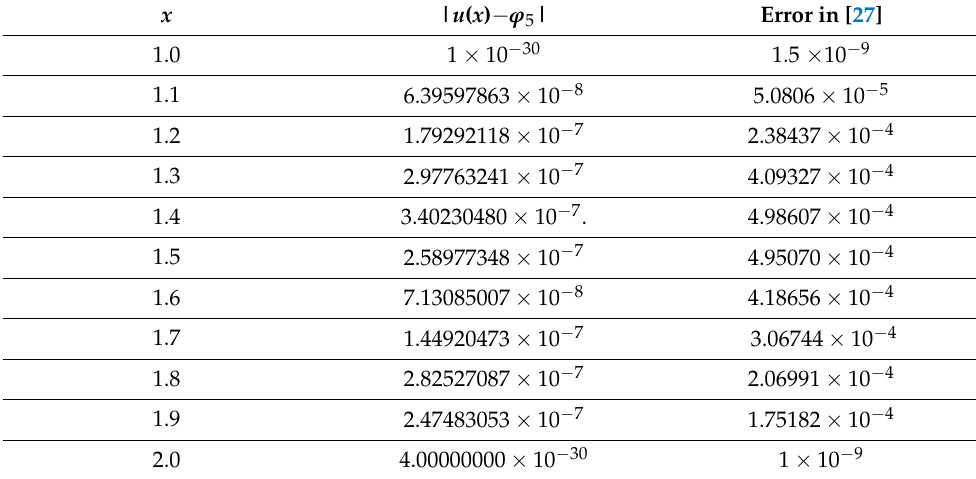
Table 1. The absolute error between the exact solution and ϕ 5 in Example 1. x | u ( x ) − ϕ 5